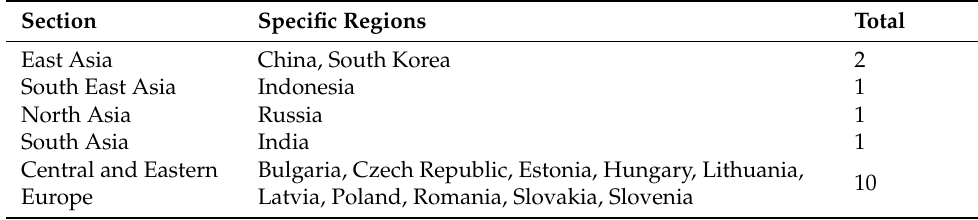
Table 1. Selected countries along the Belt and Road.